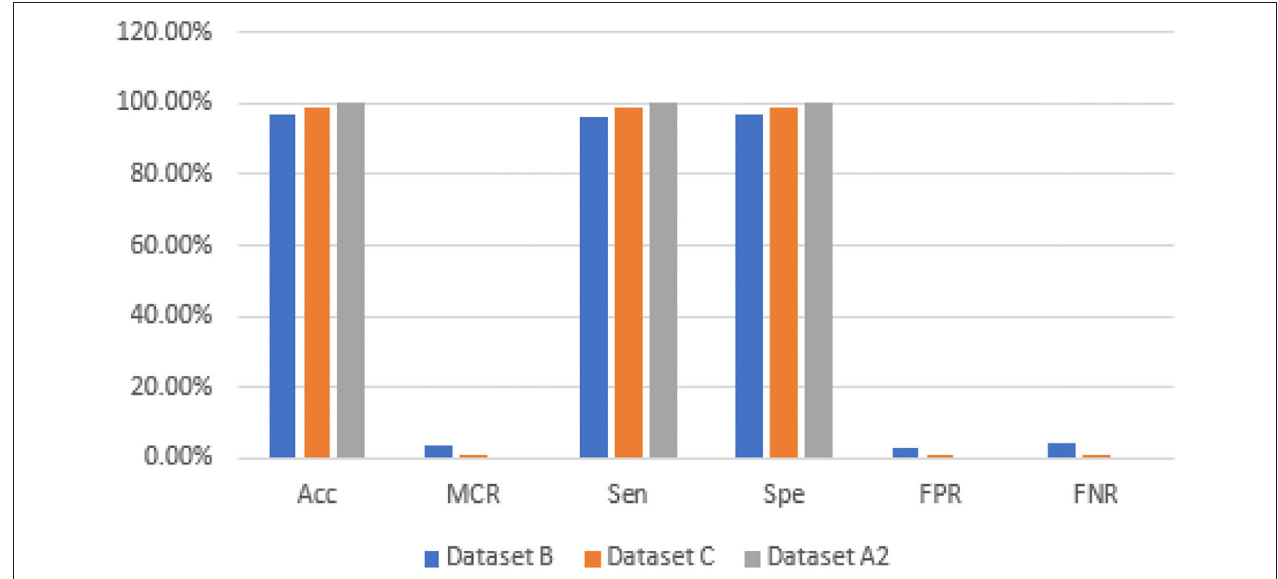
FIGURE 14 | Statistical measures of datasets B, C, and A2.